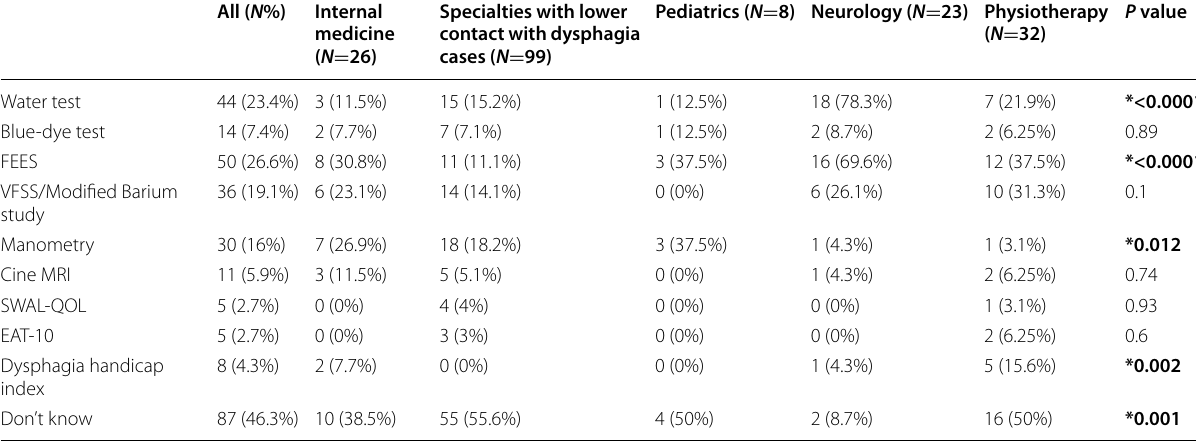
SWAL-QOL Swallowing Quality of Life, FEES fiber-optic evaluation of swallowing), VFSS video-fluoroscopic swallowing study *Significant P value < 0.05